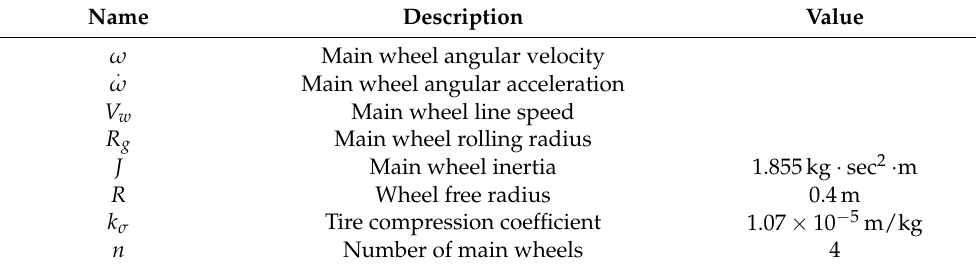
Figure 2. Force analysis diagram of a single main wheel. Table 4. Parameters of the main wheel.